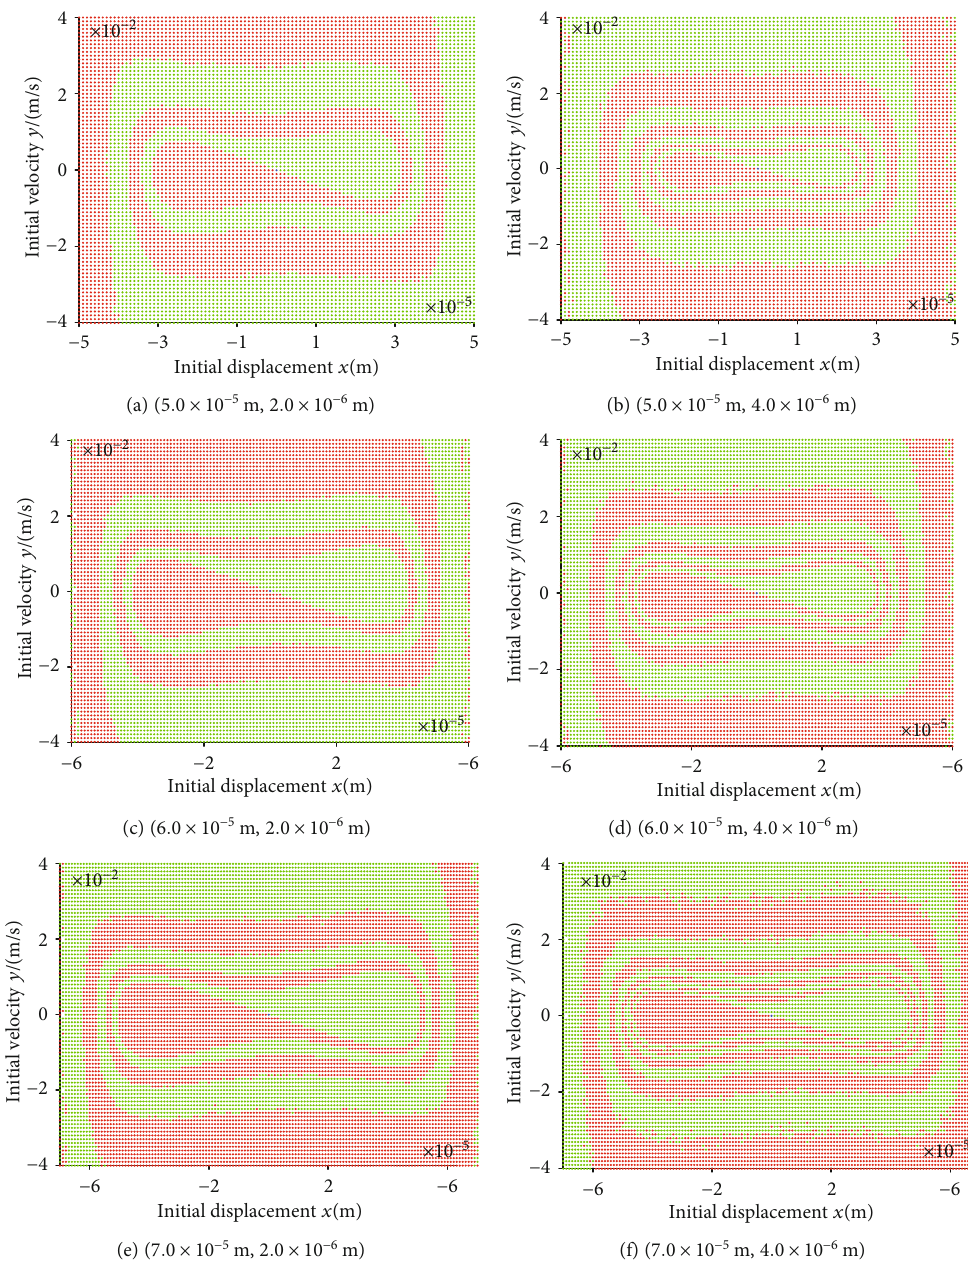
Figure 36: Basin of attraction under di ff erent